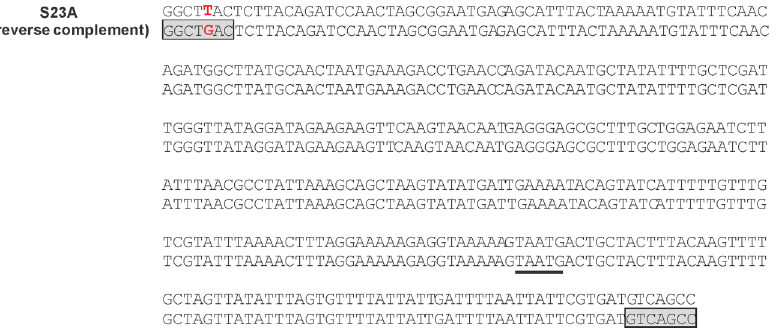
Table 3. Differentially expressed genes of the paired A. actinomycetemcomitans strains by transcriptome analysis.